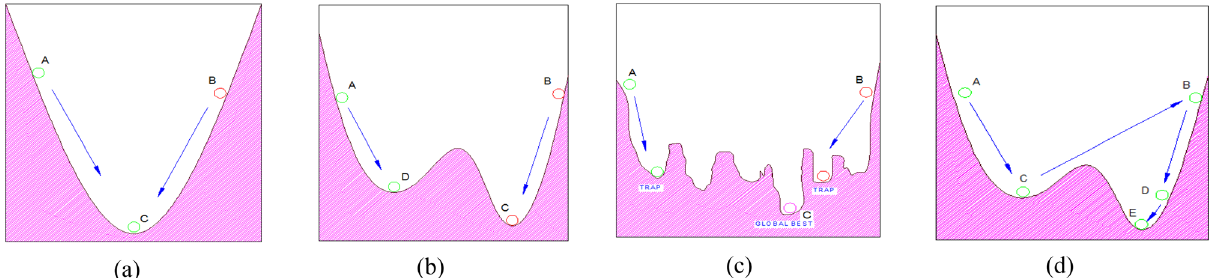
Figure 1. The process of determining the best solution using GD techniques of ANN ( a ) one local minimum, ( b ) less local minima, ( c ) many local minima; ( d ) proposed